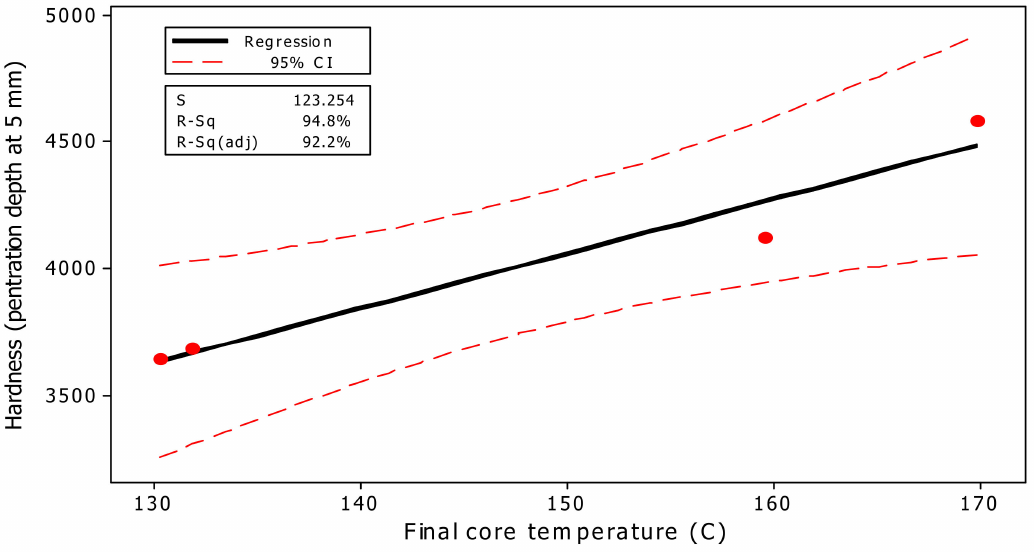
Figure 9. Fitted-line plot between hardness (at 5 mm depth of penetration) versus final core temperature ºC (at 480 s) for the four treatments studied in the present